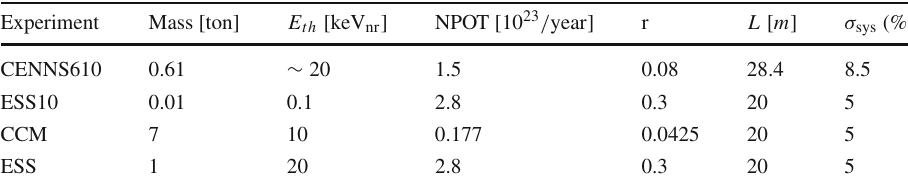
Table 2 Experimental configurations for future CE ν NS detectors considered in our